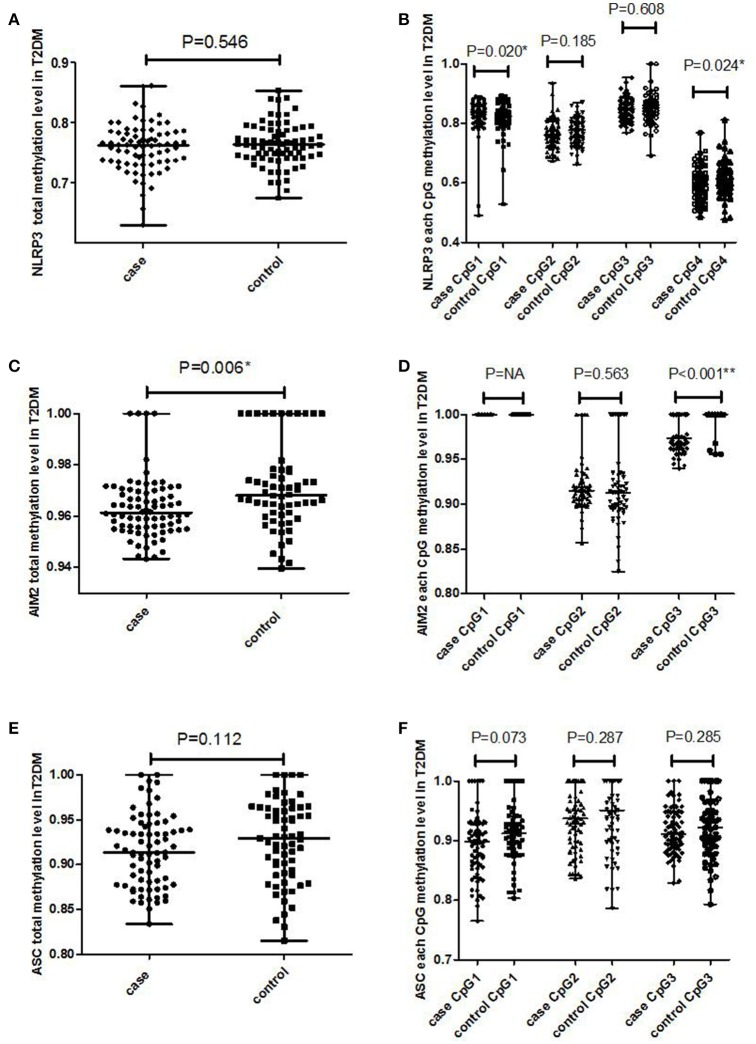
The methylation level of promotor region in NLRP3, AIM2, and ASC genes in T2DM cases and healthy controls. (A) Total methylation level in NLRP3 gene; (B) each CpG methylation level in NLRP3 gene; (C) total methylation level in AIM2 gene; (D) each CpG methylation level in AIM2 gene; (E) total methylation level in ASC gene; (F) each CpG methylation level in ASC gene. The Mann-Whitney test *P < 0.05, **P < 0.001.